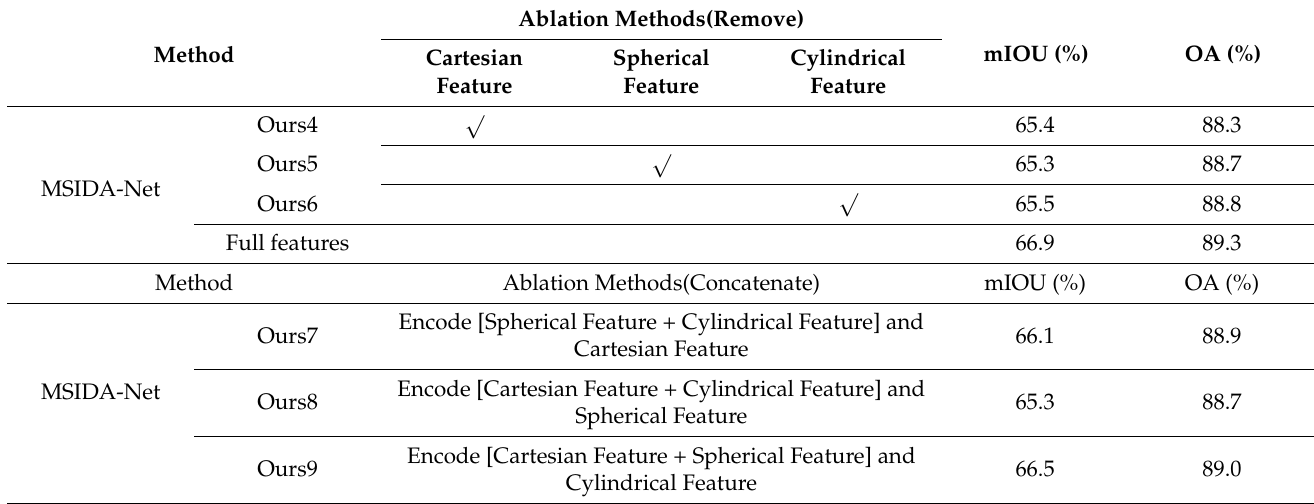
Table 5. The ablation results of the coordinate system features.